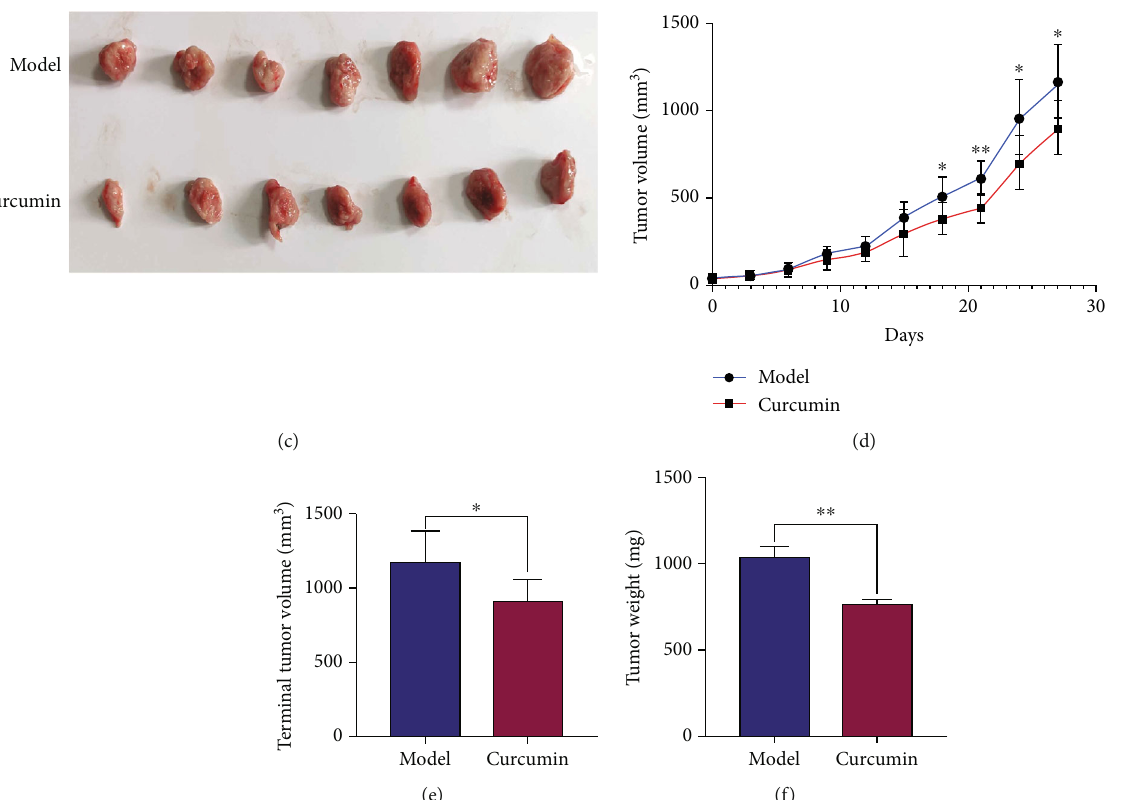
Figure 2: Curcumin inhibits the proliferation of triple-negative breast cancer. (a) In vivo bioluminescence imaging of the breast cancer- bearing mice on day 0, day 14, and day 28 after intervention ( n = 6/group ). (b) Statistical analysis of bioluminescence value of tumor- bearing mice on day 0, day 14, and day 28 after intervention ( n = 6/group ). (c) Comparison of in situ tumor morphology between tumor-bearing model mice and curcumin treatment mice. (d) Model group and curcumin treatment group tumor growth curve during the intervention period ( n = 8/group ). (e, f) Statistical analysis of terminal tumor volume and bodyweight in the model group and the curcumin group ( n = 8/group ). NS: not signi fi cant; ∗ p < 0 : 05 and ∗∗ p < 0 : 01 by t -test, compared to the model group. Data were shown as mean ± standard errorsof the mean